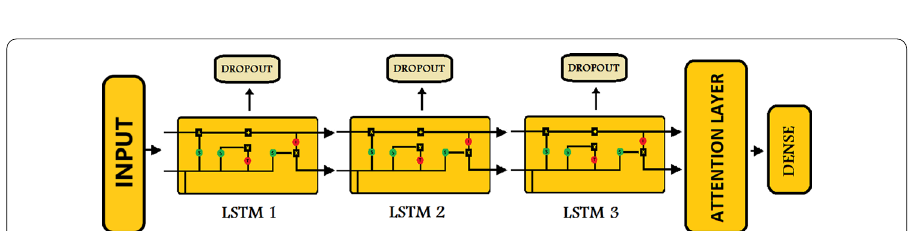
Fig. 11 The proposed LSTM-ATTENTION